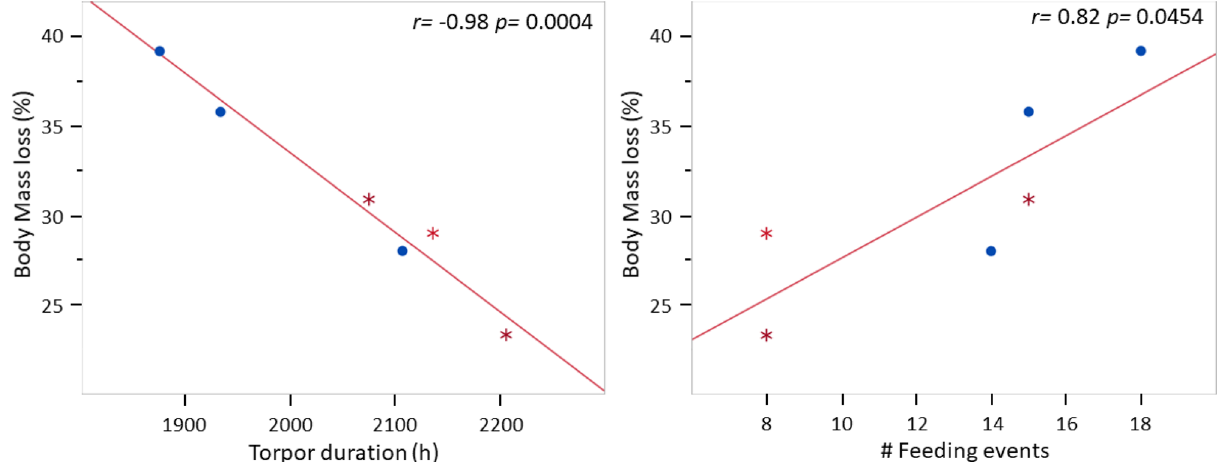
Figure 4. Linear regressions of body mass loss against cumulative torpor occurrence and feeding events. Males are represented by circles, females by asterisks. Pearson correlation coefficients are shown on right upper corner. Data collected between October 15 and January 29.